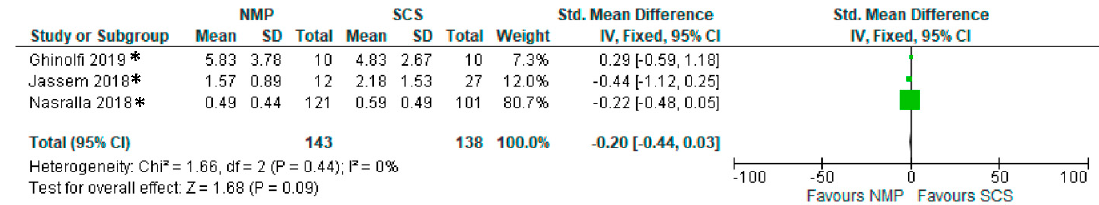
Figure 18. One week post transplantation peak serum total bilirubin in studies comparing NMP to SCS. In papers marked with “ * ”, mean and standard deviation were calculated using the method described by Wan 2014 [5].